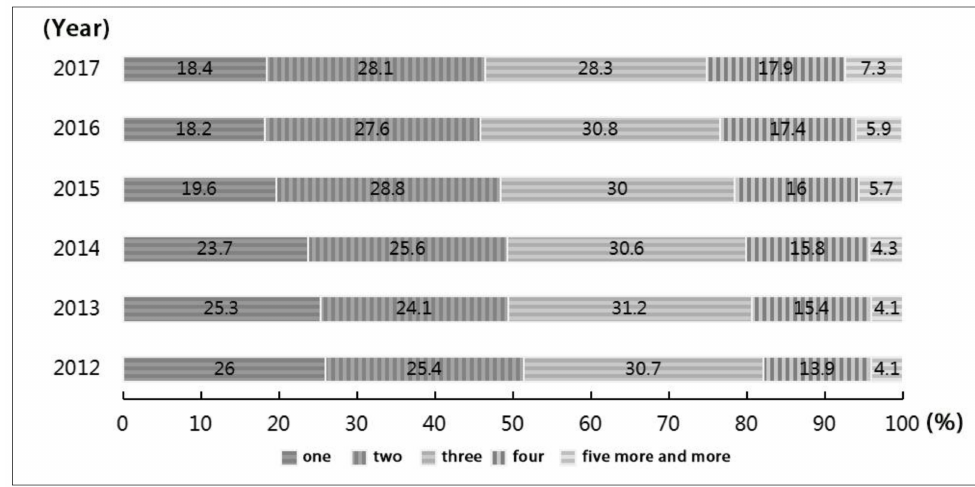
Figure 4. Household size distribution of floating